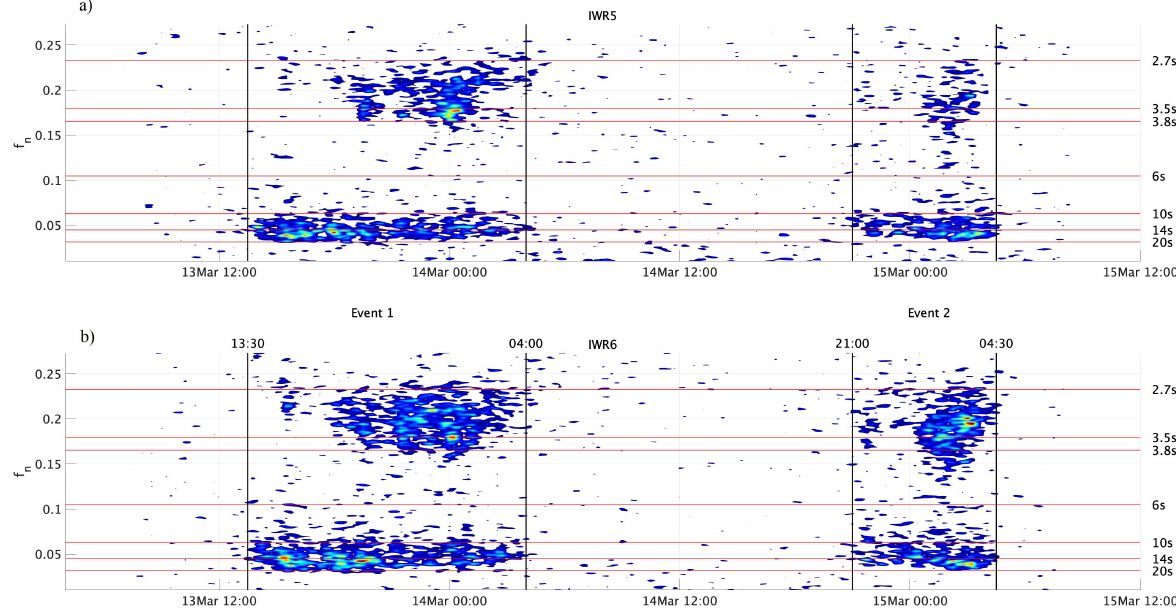
Figure 5. Welch periodogram for ( a ) IWR5 and ( b ) IWR6 with time ( x -axis) from early 13 March through noon 15 March, 2020 versus normalized frequency ( y -axis left). Selected periods (red lines) have the seconds labeled on the y-axis at right. Wave events appear from 13:30 on 13 March and persist for about 14 h then begin again around 21:00 h on 14 March and last for about 7 h. Black vertical lines mark the start and end of the wave events, labeled Event 1 and